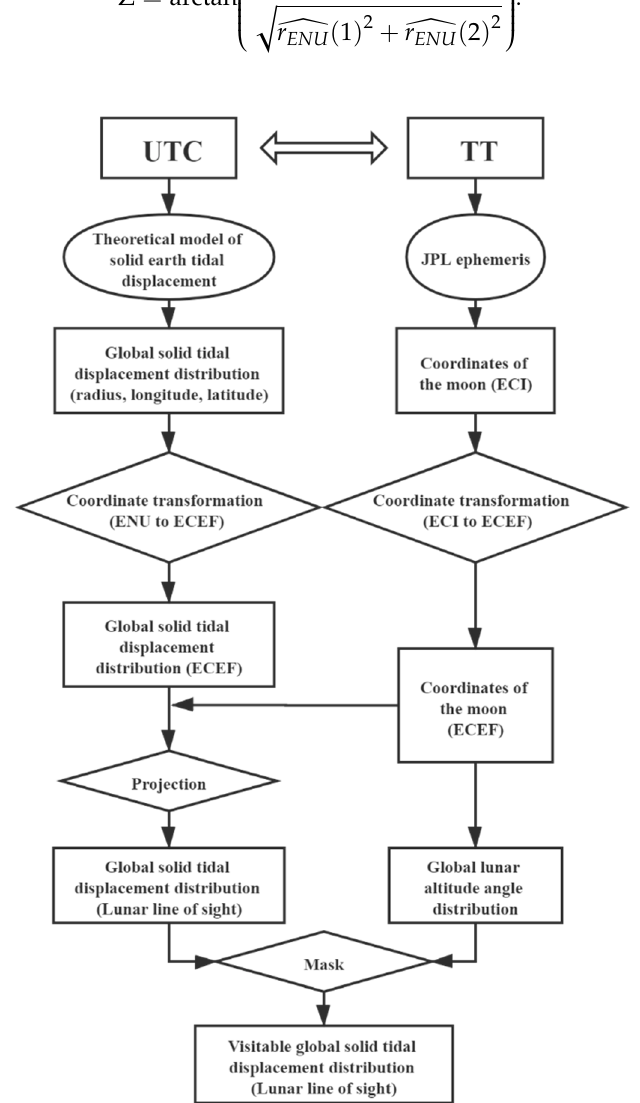
Figure 2. Flowchart of displacement distribution from lunar view. The time input into the tidal model and Jet Propulsion Laboratory (JPL) ephemeris are coordinated universal time (UTC) and terrestrial time (TT), respectively. The three components of the solid earth tides (SET) displacement point to the same direction as the local Cartesian coordinates coordinate system (ENU). Then, the displacement information and position information of the moon are unified into the earth-centered, earth-fixed coordinate system (ECEF). After the displacement projection, the displacement distribution of the SET is masked by the observable range obtained from the lunar altitude